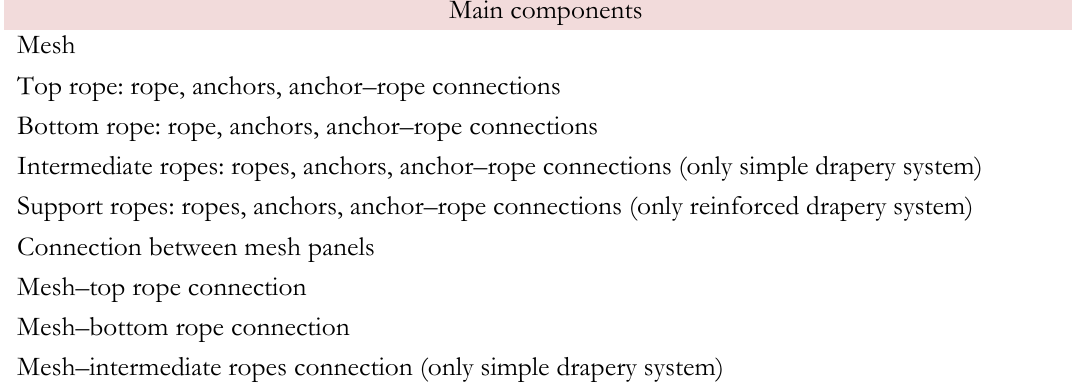
Table 1: Main components of a drapery mesh